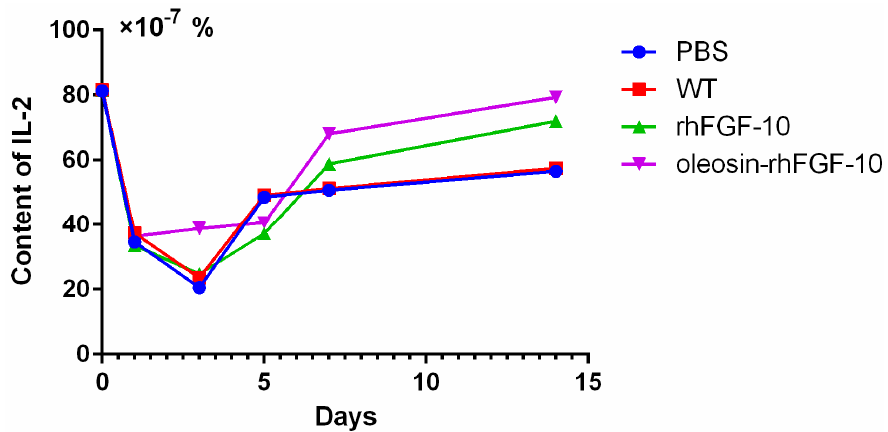
Figure 7. IL-2 was measured by enzyme-linked immunosorbent assay (ELISA) in the process of wound healing. Mice were randomly selected from each group and euthanized on days 1, 3, 5, 7 and 14. The entire experiment was repeated three times and results were expressed through a mean.